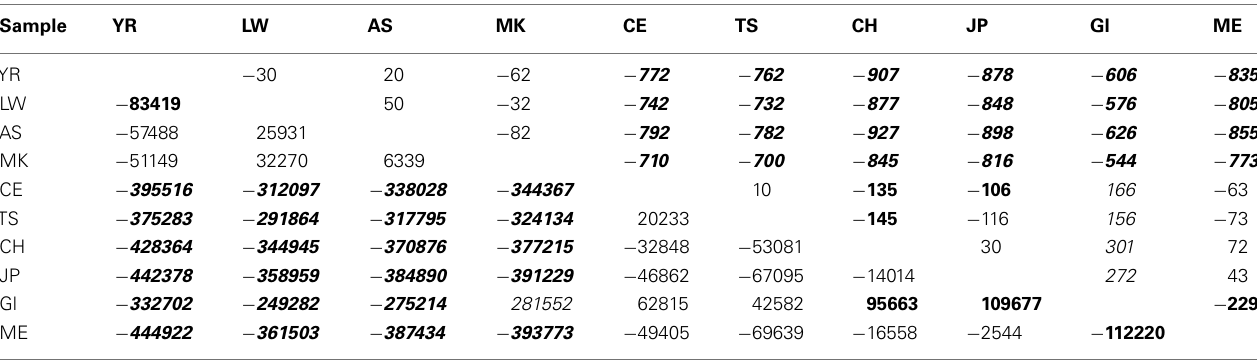
Table 2 | Pairwise population comparisons usingTukey’s HSD method for the number of derived genotypes per-individual genome (below diagonal) and number of functional homozygous derived genotypes (above diagonal).